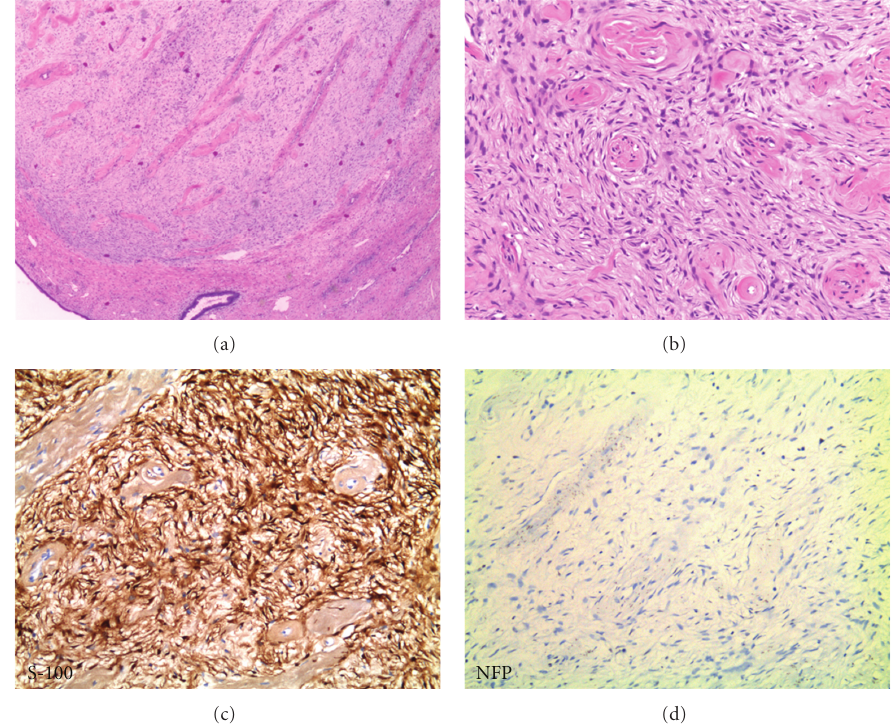
Figure 1: (a) Low-power view (2.5x) of the lesion showing a well-circumscribed mass with spindle cell proliferation and thick-wall hyalinized blood vessels. (b) Higher power view (10x) of the lesion. (c) Spindle cell component with strong S-100 immunoreactivity (10x). (d) Negative stain for NFP